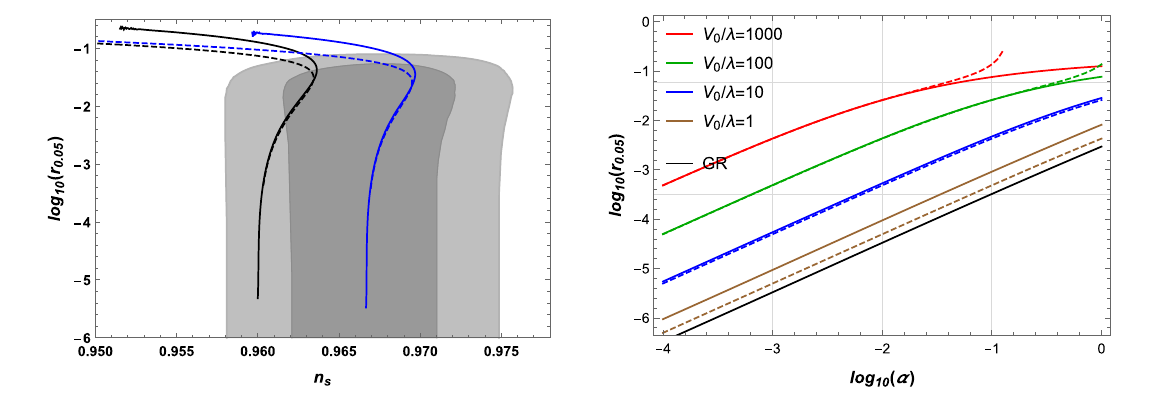
Fig. 1 The left panel shows the marginalized 1 σ and 2 σ confidence levelcontoursfor n s and r fromPlanck2018andBICEP2results[19,20] and the results for the E-model with n = 1 and α = 0 . 001 in brane inflation.Thedashedlinedenotestheanalyticalapproximation (24)and (25)andthesolidlinecorrespondstothenumericalresultbyvaryingthe parameter V 0 /λ . The left black lines are for N = 50 and the right blue lines are for N = 60. The right panel shows the relation between r and